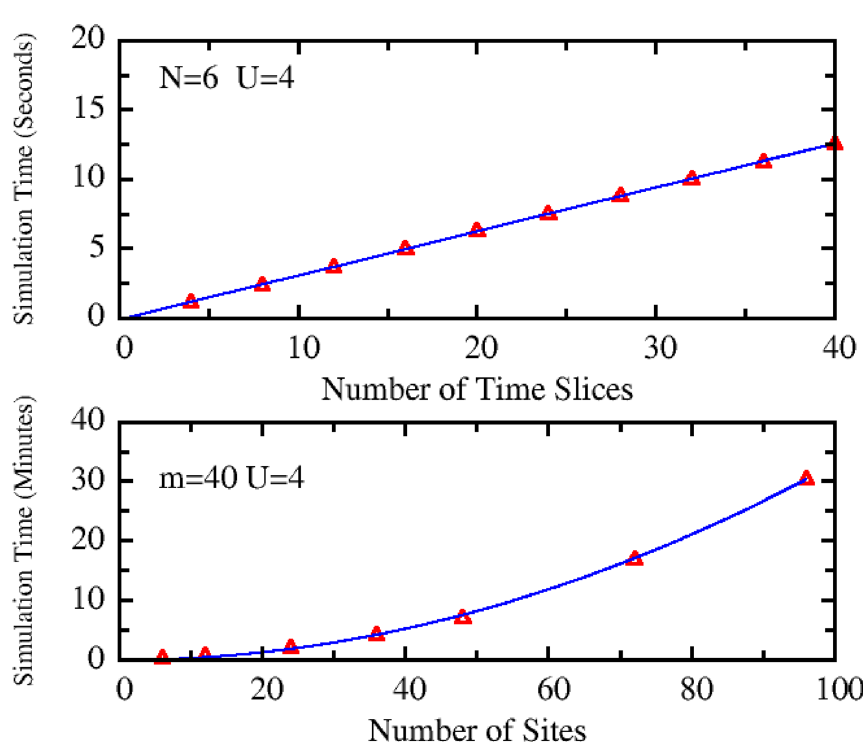
Figure 4. The simulation time as a function of the number of time slices m for N = 6 (upper panel) and the number of lattice size for m = 40 (lower panel). The symbol and solid line represent the QMC data and the fitting curves, respectively. Here the linear fitting to QMC data is adopted in upper panel, while the quadratic function is used to fit QMC data in lower